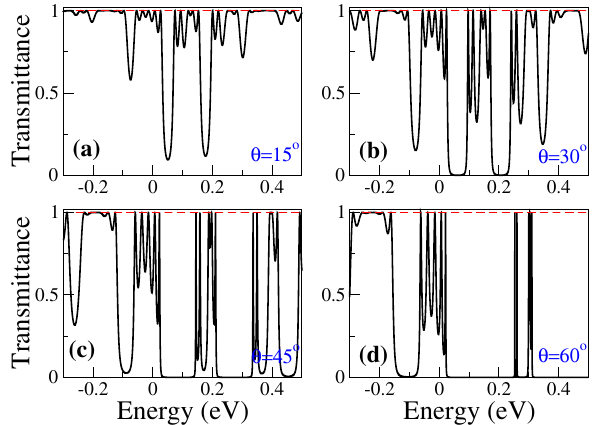
Figure 3. The same as Fig. 2, but for BPGGSLs with d W 1 < d W 2 . In particular, d W 1 = 50 a and d W 2 = 60 a .